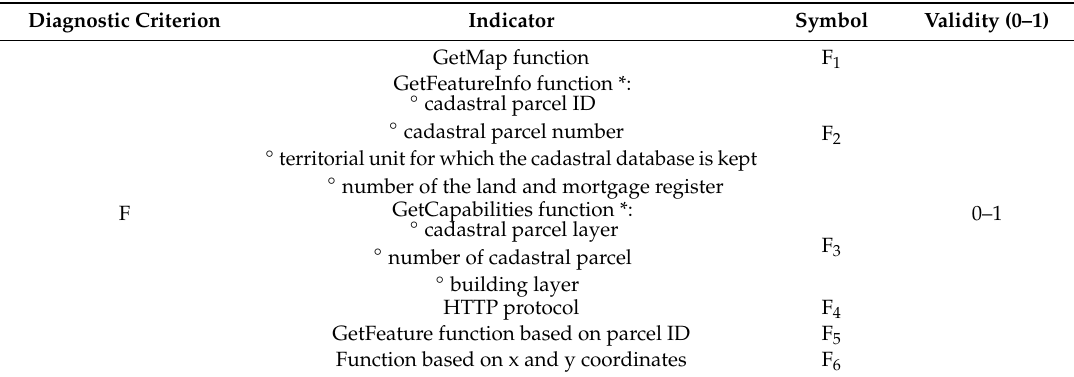
Table 7. Standardization of WMS and WFS.